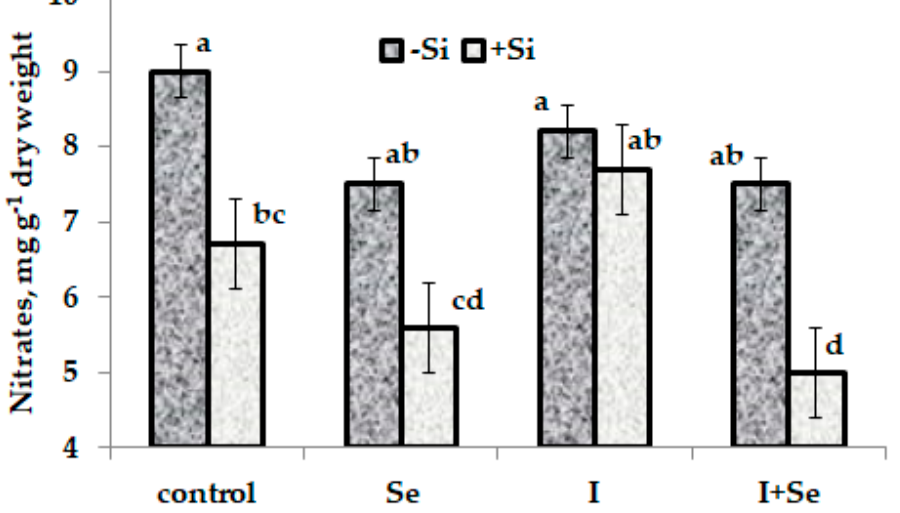
Figure 2. Effect of Si on nitrate accumulation in control chervil plants and plants fortified with I and/or Se. Values with the same letter do not differ statistically according to Duncan test at p < 0.05. Though both nano- and bulk Si are known to improve nitrogen uptake, assimilation, remobilization and induce amino acids biosynthesis under soil application [35–38], a significant decrease in nitrate accumulation in chervil treated with nano-Si, Se + nano-Si and Se + I + nano-Si is the first observation of foliar nano-Si effect on nitrate metabolism. Lack of any effect of nano-Si on nitrate accumulation in chervil under I supply demonstrates a substantial different interaction between Se and nano-Si, and between I and nano-Si. In this respect, further investigations including a comparison between nano- and bulk Si treatments are needed to unveil peculiarities of Se-I-Si